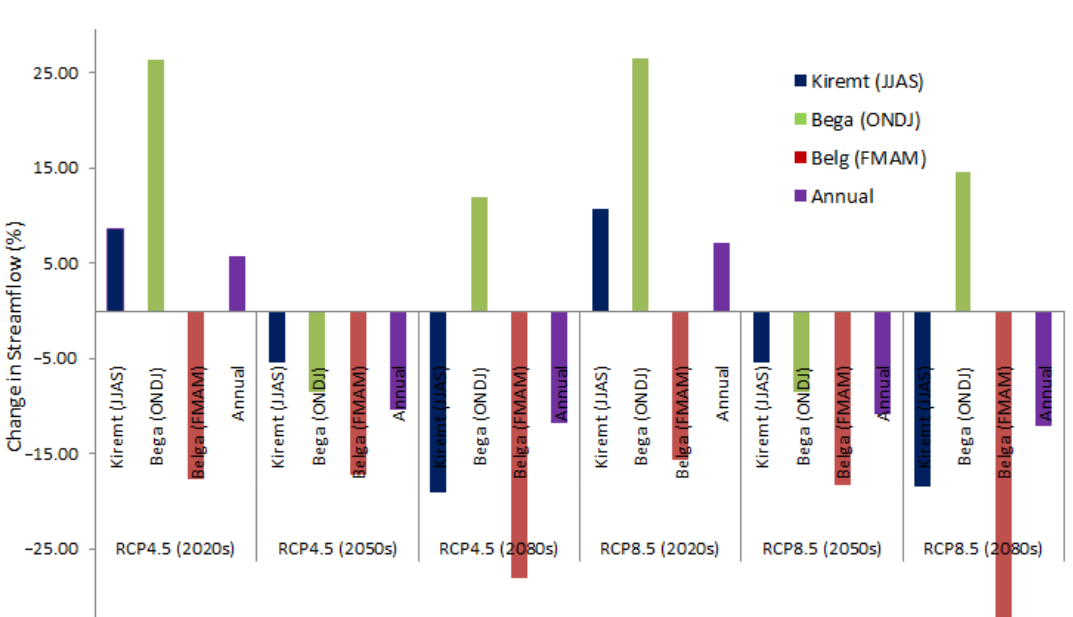
Figure 11. Seasonal and annual change in streamflow for three time periods under RCP4.5 and RCP8.5.